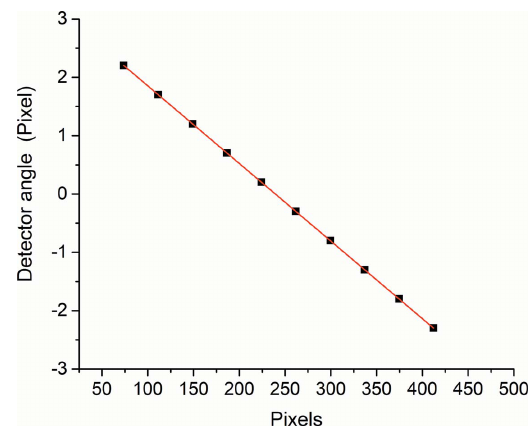
Figure 3 The relationship between the detector angles and the related